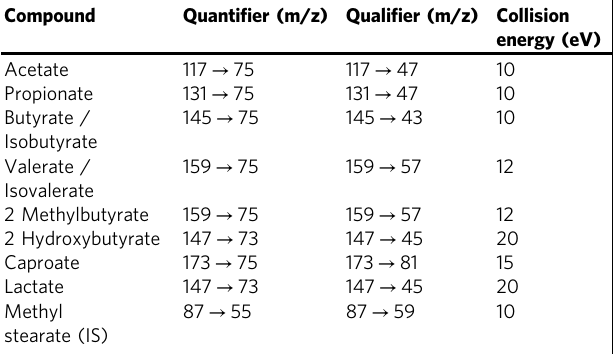
Table 1 GC-MS conditions used to analyse SCFA and carboxylic acid